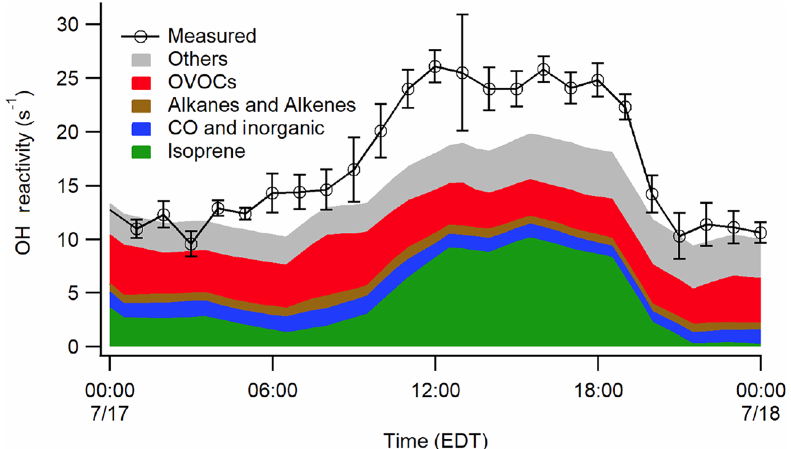
Figure 9. Median OH reactivity measurements from 17 July in comparison to modeled reactivity on this day from the MCM 3.3.1 mechanism.